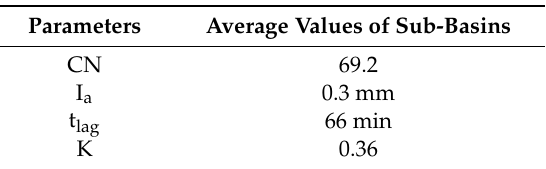
Table 4. Calibrated parameters of 1970s and